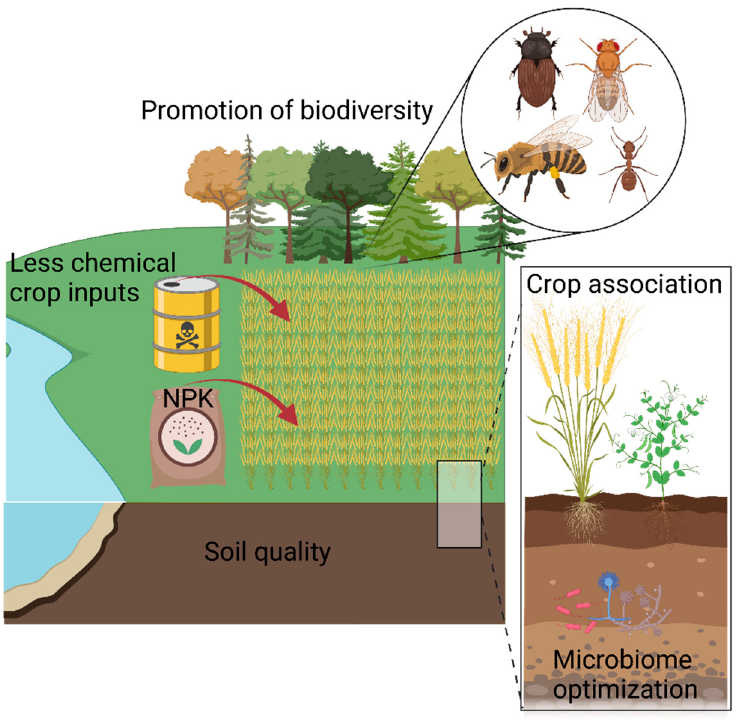
Figure 2. A sustainable agro-ecological system. The promotion of biodiversity includes the protection of various pollinator species and plant species in a given agro-ecological system. The reduction in chemical inputs implies that pest control and the use of fertilizers should be replaced by genetic improvement and alternative crop practices. Created with (BioRender.com).